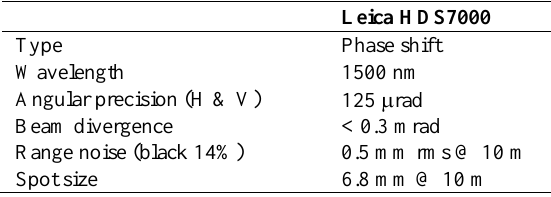
Table 1. Terrestrial Laser Scanner technical specifications.